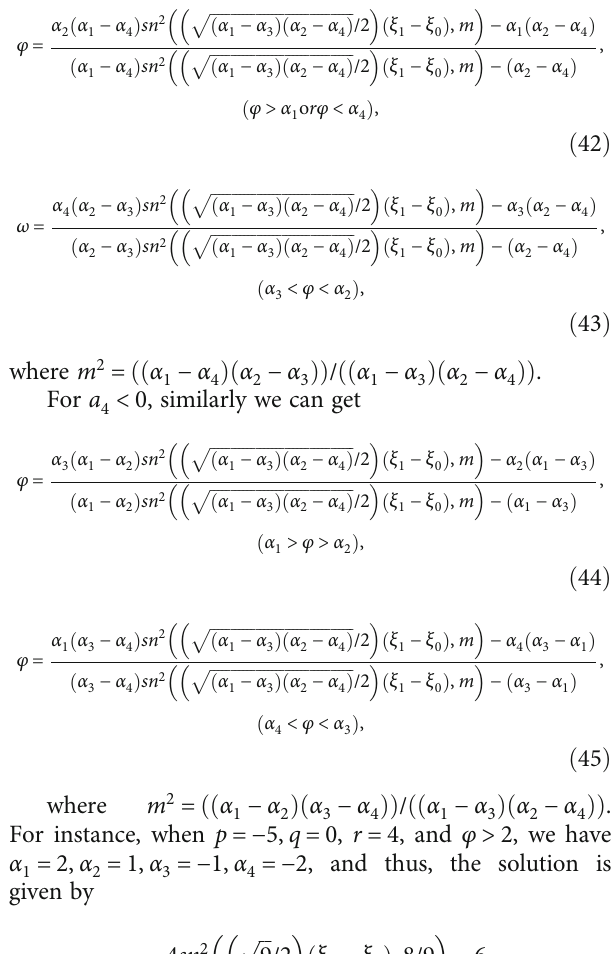
ffiffiffiffiffiffiffiffiffiffiffiffi E 2 − 1